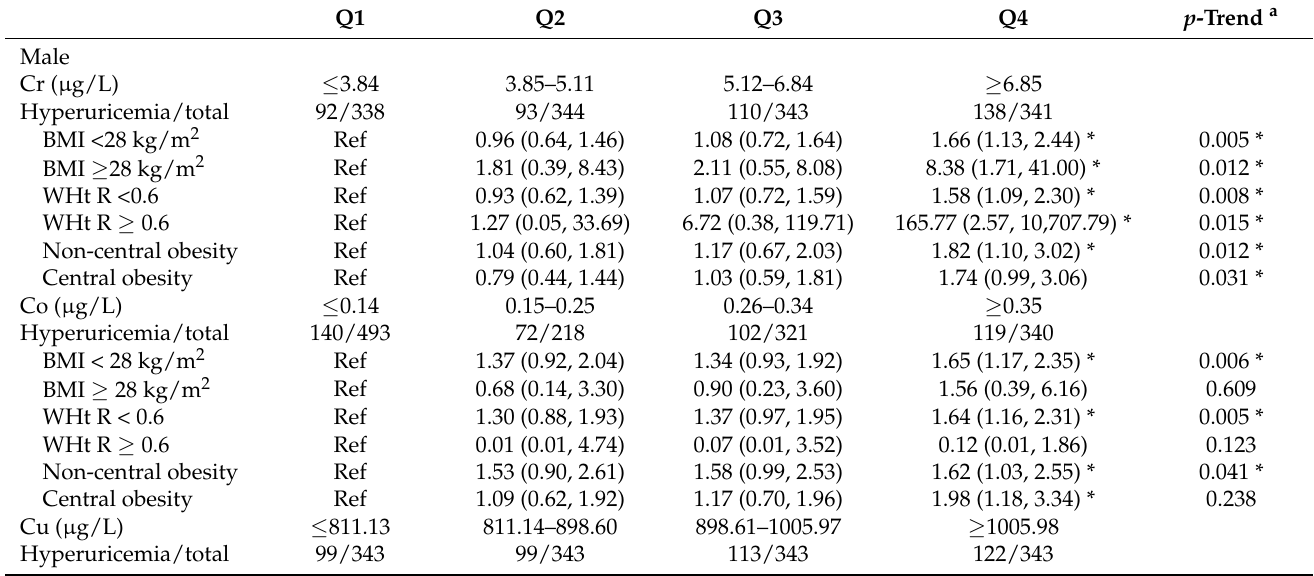
Table 4. Adjusted odds ratios for incident hyperuricemia risk in subgroups stratified by BMI, WHt-R, and central